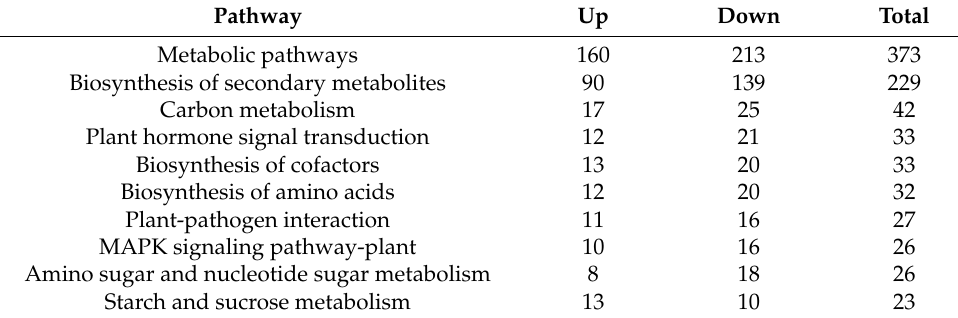
Table 2. Top 10 pathways enriched in the “H 2 O7d vs. MgO7d” group.